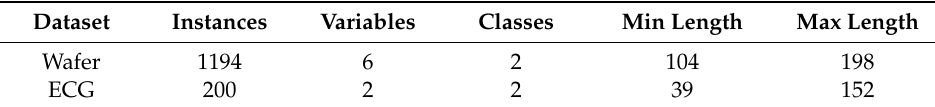
Table 1. Description of